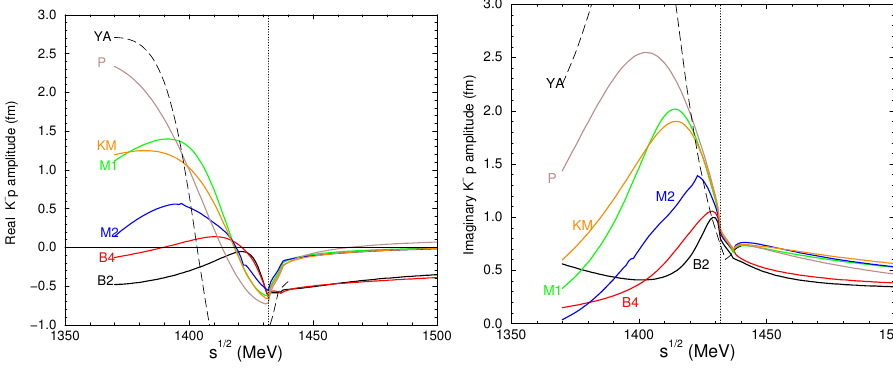
Figure 1. K − p s -wave amplitudes used in the present work, taken from chiral SU(3) meson-baryon coupled-channel dynamical models discussed in [10] and denoted there by KM for Kyoto-Munich [11], P for Prague [12], M1 and M2 for Murcia [13], and B1 and B2 for Bonn [14]. The YA curves (kindly supplied by T. Hyodo) are for a fixed energy-independent potential of [15]. Vertical dotted lines indicate threshold